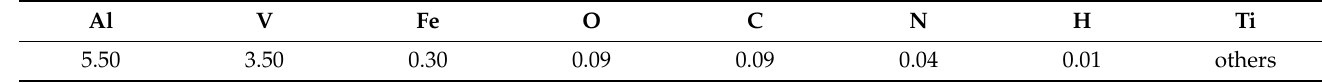
Table 1. Main chemical constituents of TC4 titanium alloy.